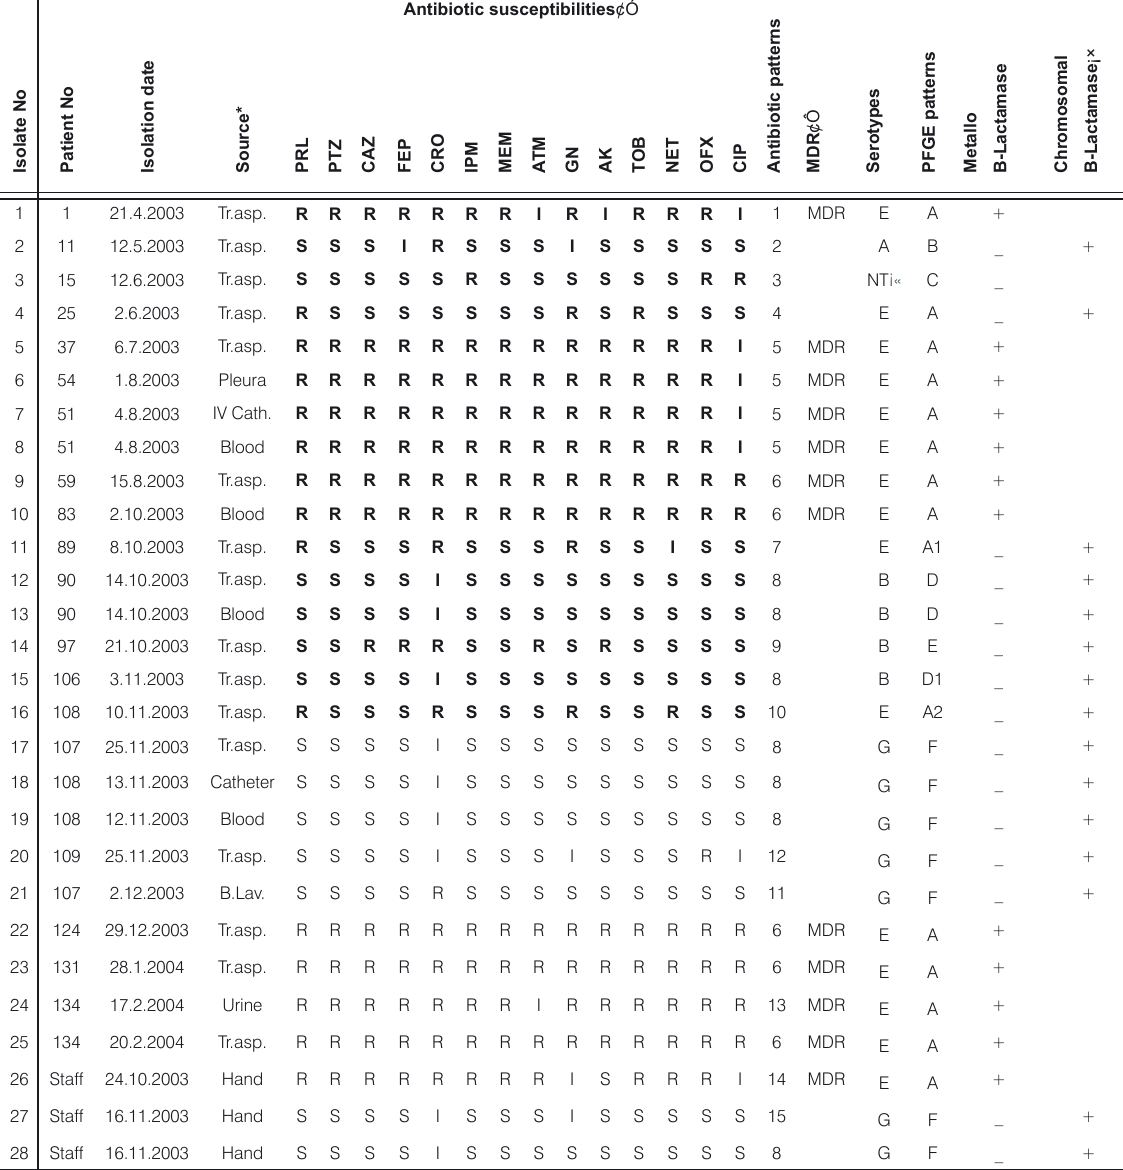
Table 2. The characteristics of Pseudomonas aeruginosa